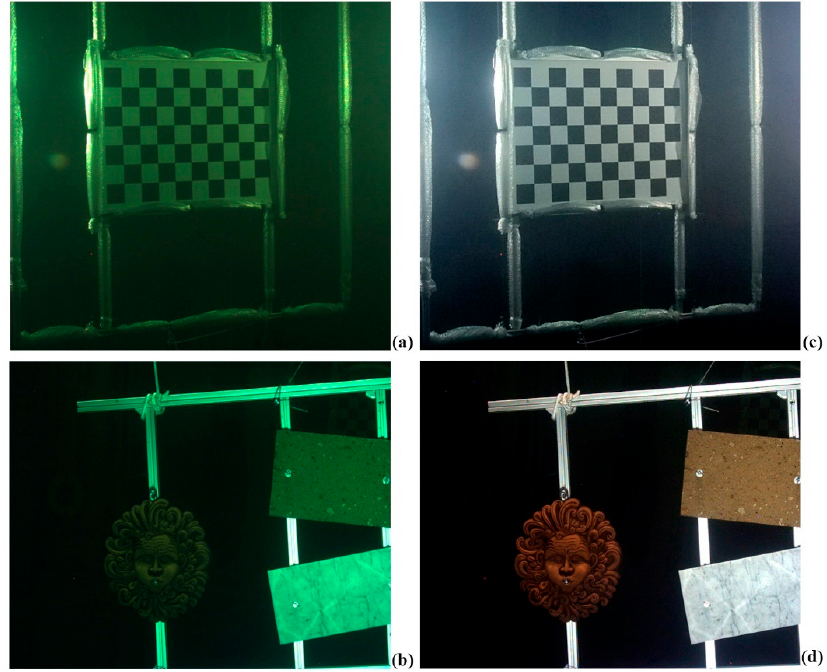
Figure 13. Optical images of the orientation rig ( a ) and target objects; ( b ) after the application of the color enhancement algorithm ( c , d ).